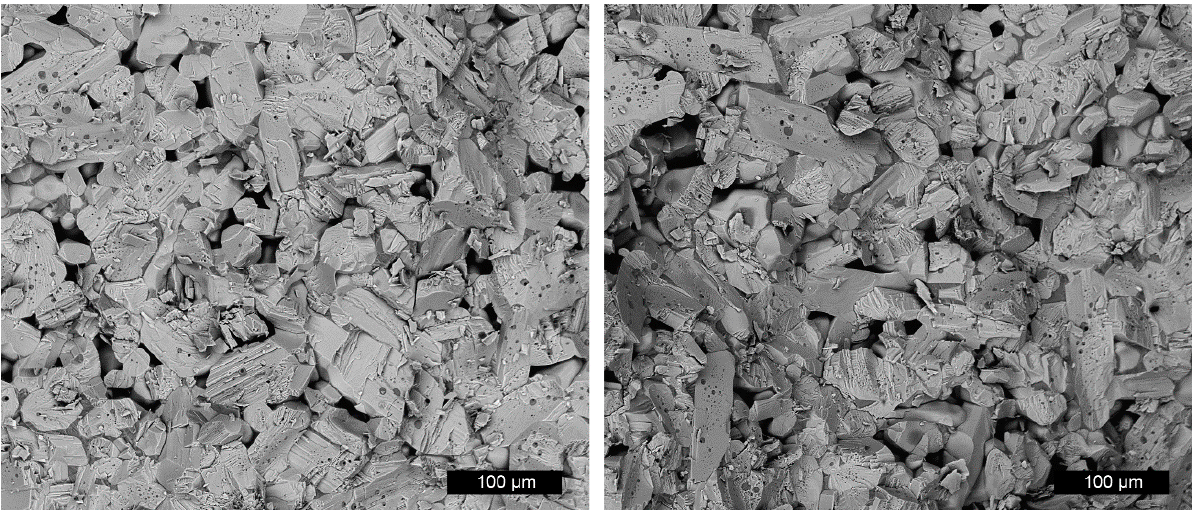
Figure 4. SEM-BSE images taken from the fracture edge of an (intentionally) broken pellet, revealing a dense, nonregular texture with elongated SmPO 4 grains.